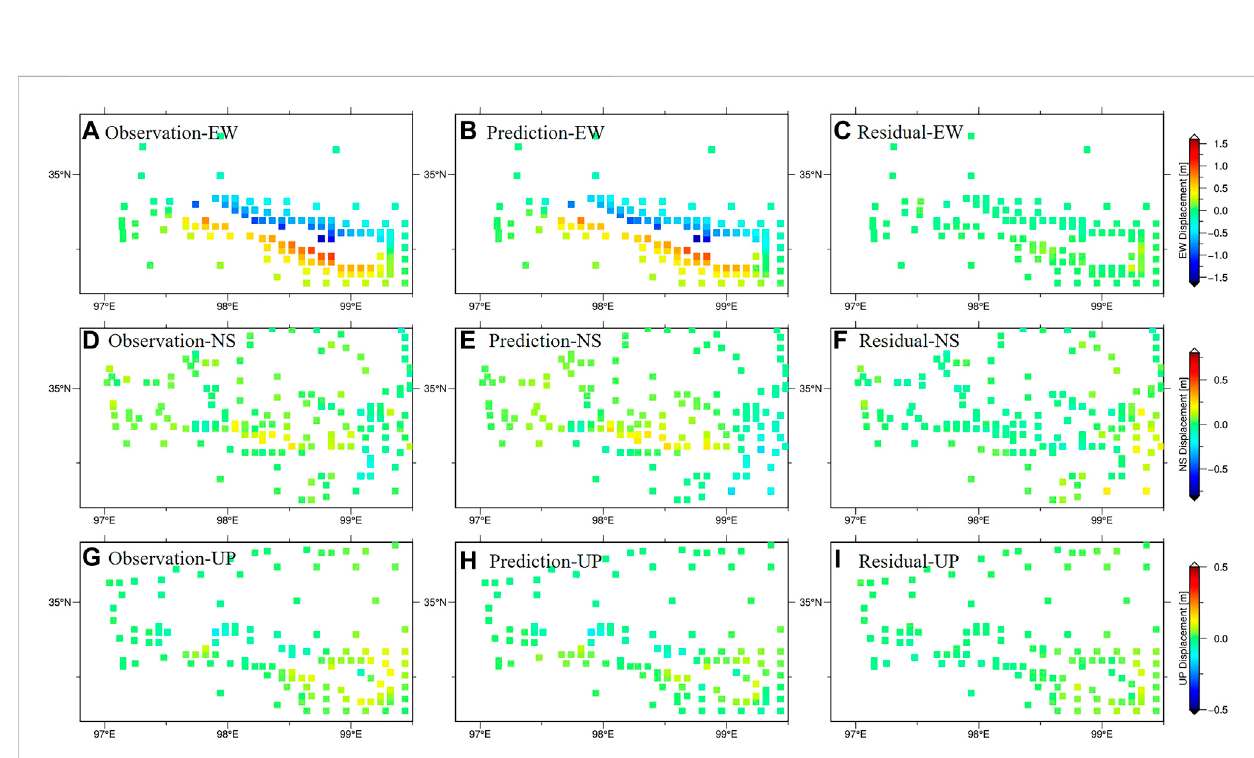
simultaneously calculated in SM-VCE when resolved from 3D deformation. According to Figure 13, the maximum shear strain is located at a zone around 99 ° E. This is where that fault extends to the east and orientation changes from NS to NW. Wu et al.